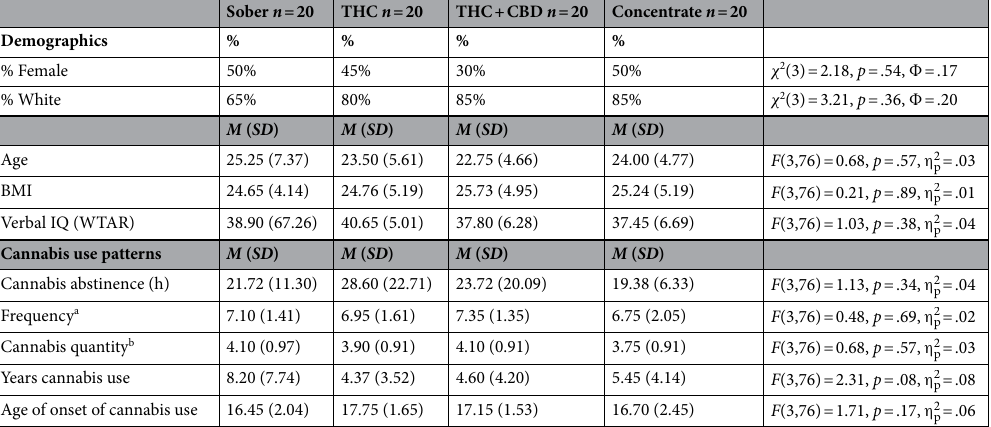
Table 1. Demographic characteristics and cannabis use patterns across groups. BMI body mass index, WTAR Weschler’s Test of Adult Reading. a Participants rated the number of days of the past month on which they